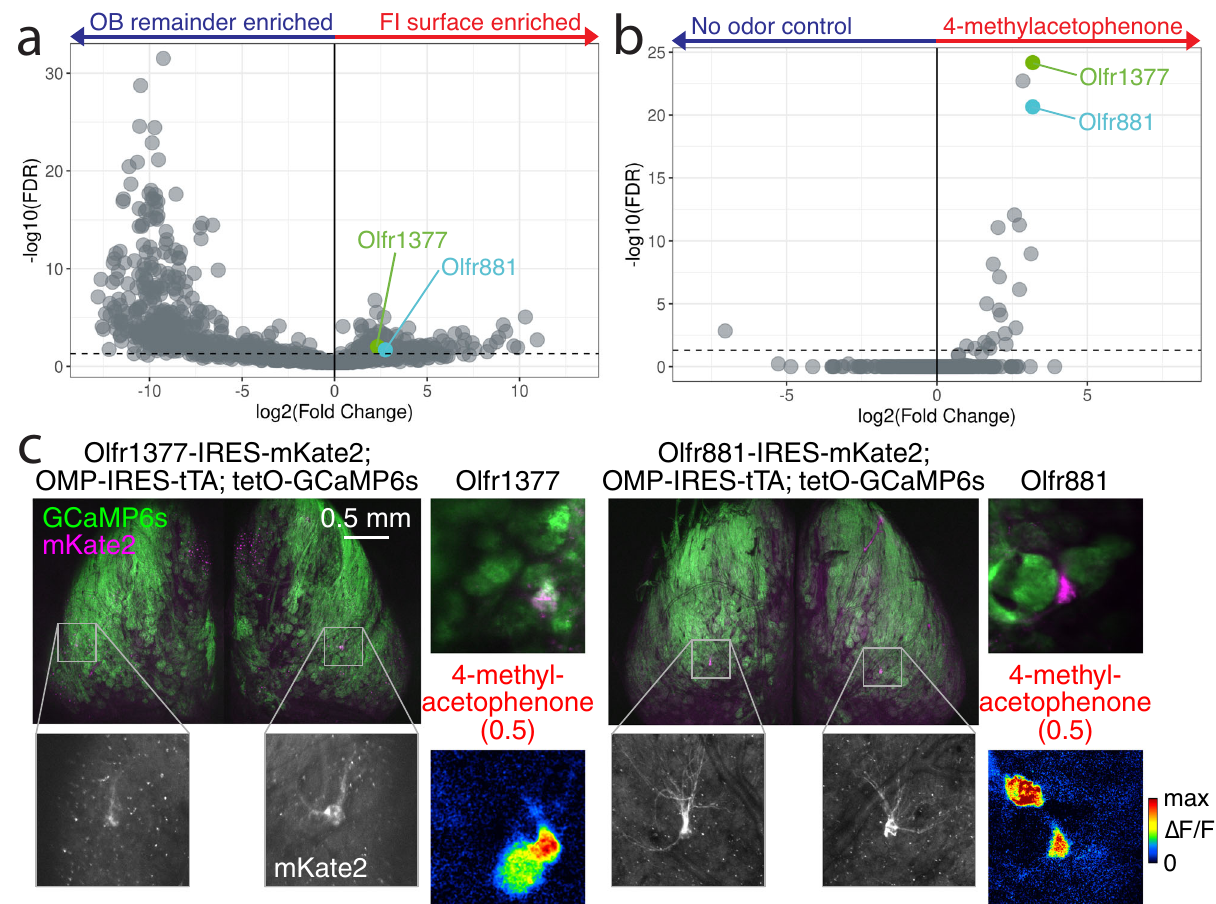
Fig. 8 | Deorphanization of Olfr1377 and Olfr881. a Volcano plot comparing enrichment of OR transcripts in functional imaging surface and OB remainder samples. The FI-surface-enriched OR transcripts Olfr1377 and Olfr881 are labeled in green and cyan, respectively. Source data provided as a Source Data fi le. b Volcano plot comparing enrichment of OR transcripts in pS6-IP RNA-Seq stimulation with 1% 4-methylacetophenone. The highly ranked responding ORs, Olfr1377 and Olfr881, are labeled in green and cyan, respectively. Source data provided as a Source Data fi le. c Whole-mount confocal maximal intensity